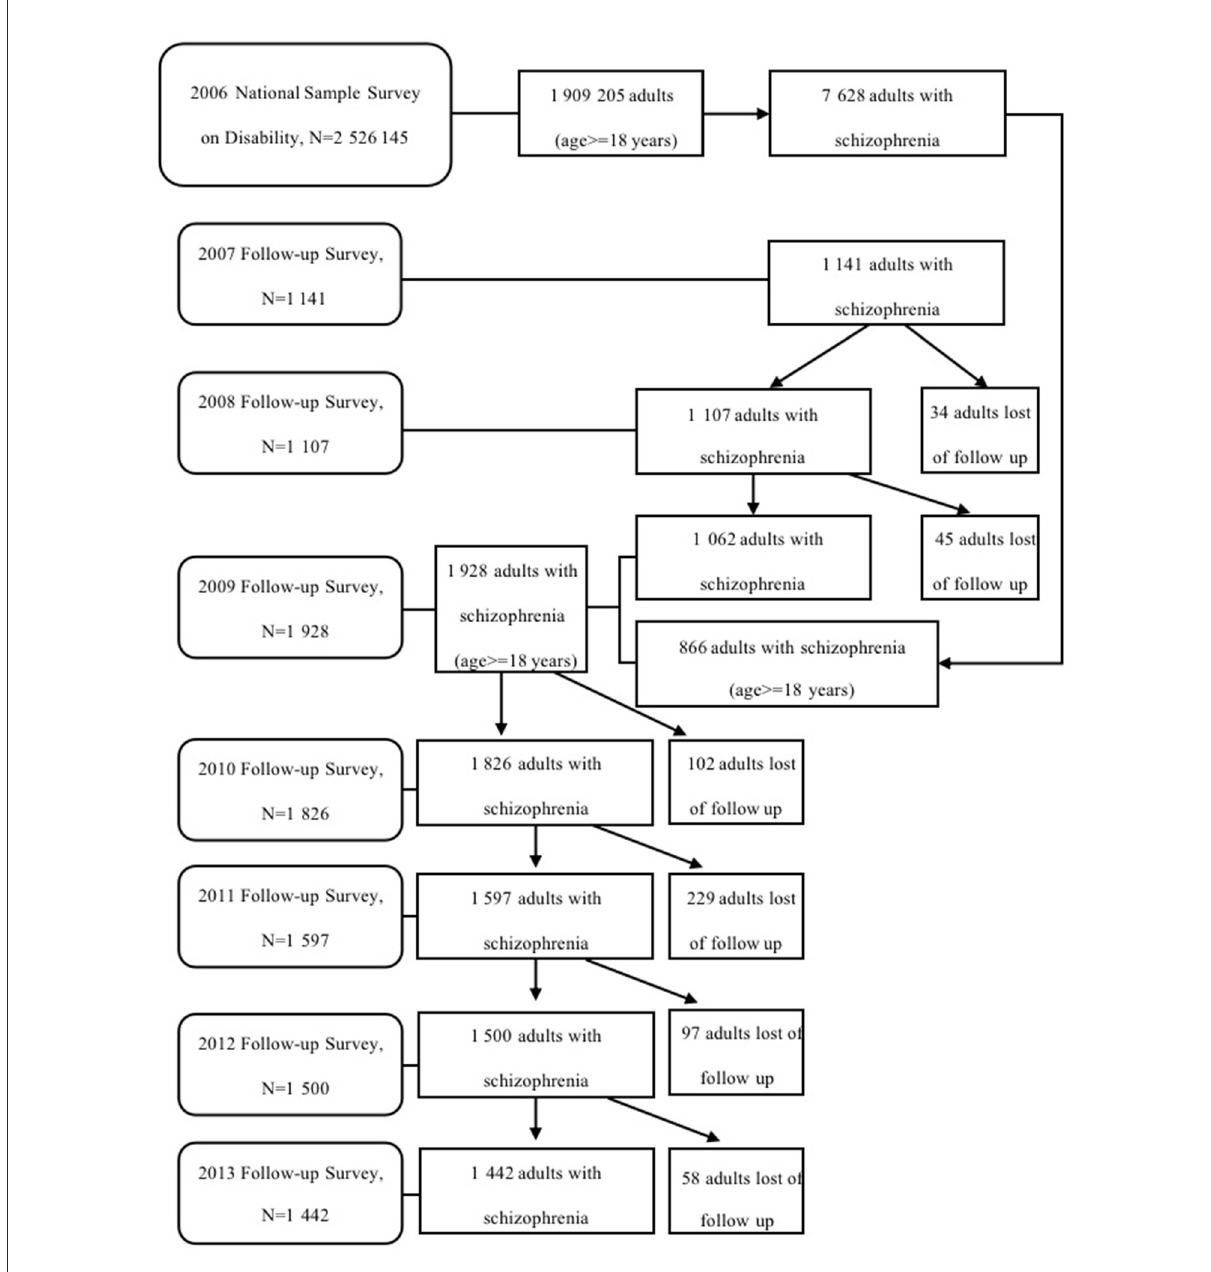
FIGURE1 Flow chart of the study sample.